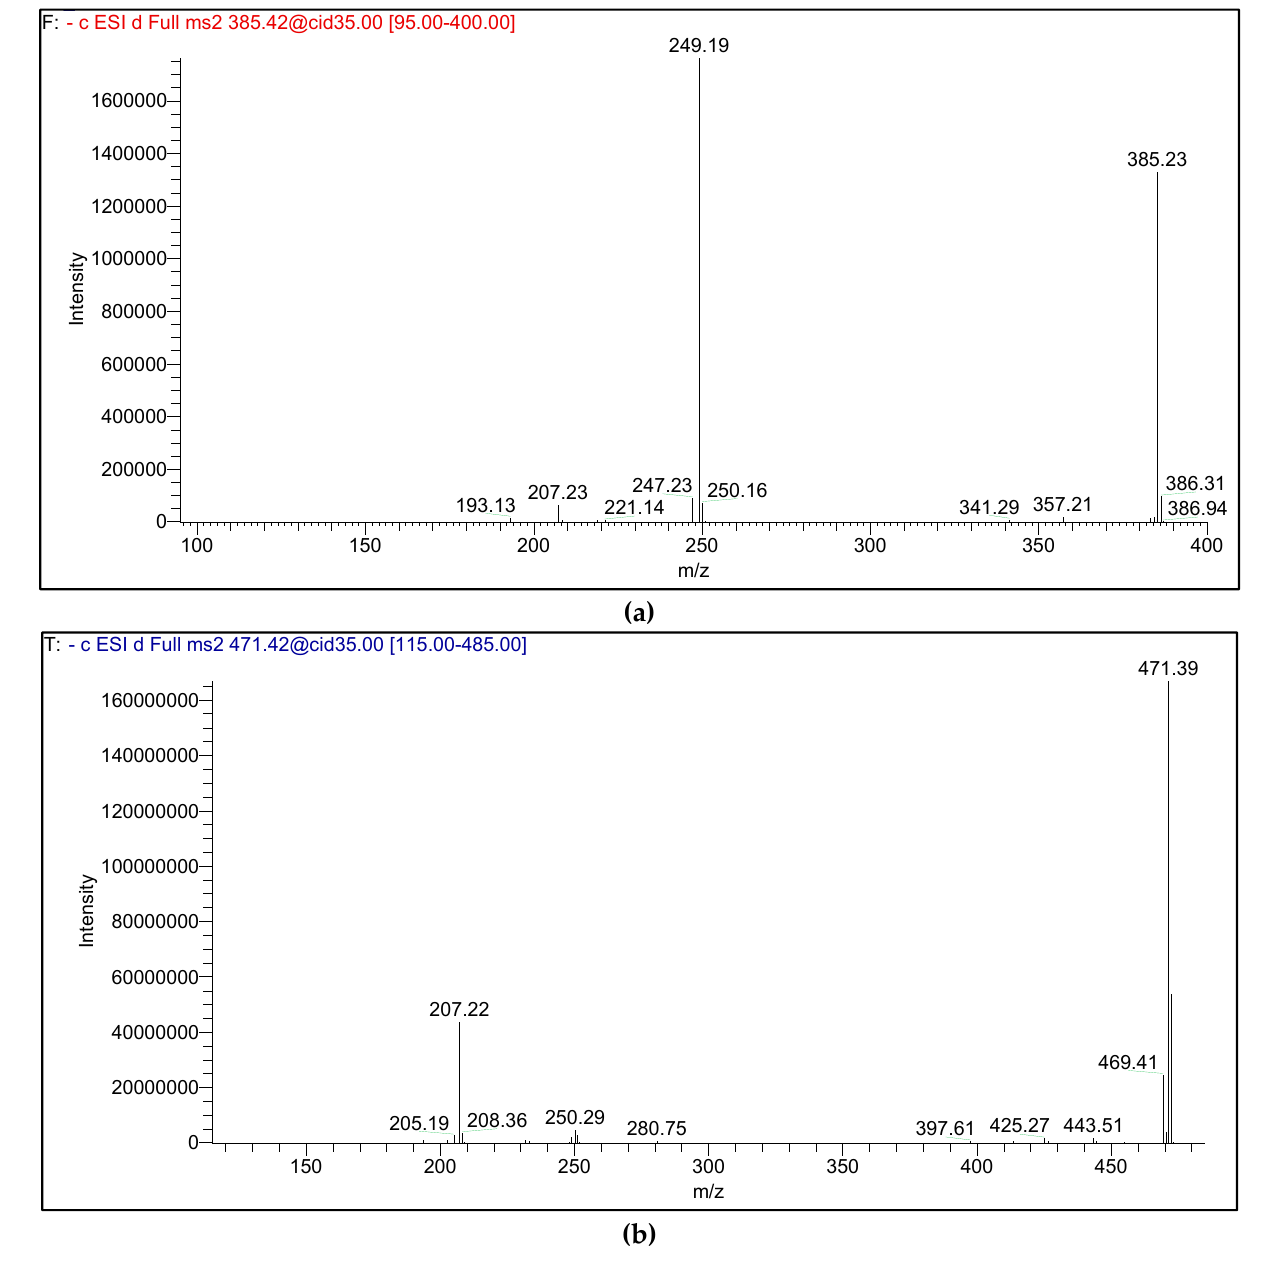
Figure 4. MS-MS product ions of [M − H] − ions at ( a ) m/z 385 of monoterpene hydrocarbons euglobals ( b ) m/z 471 of sesquit- erpene alcohols macrocarpals.